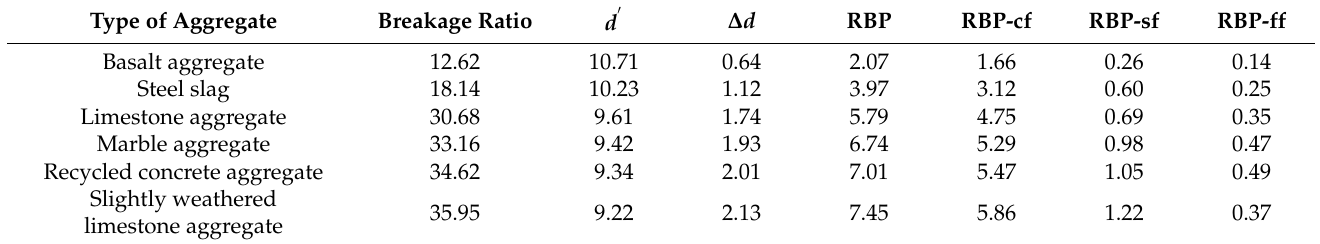
Table 8. Results of aggregate crushing characteristics after Marshal hammer compaction.